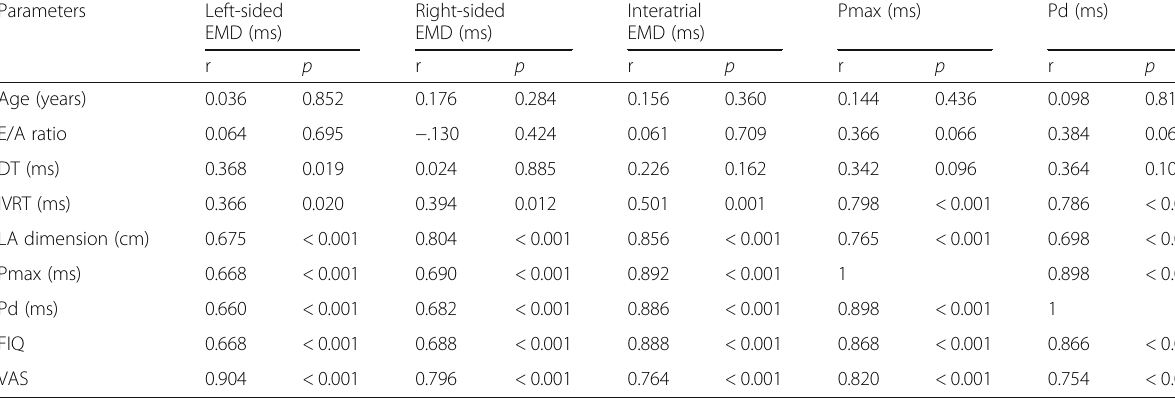
Table 5 Correlations between echocardiographic parameters of atrial conduction times, electrocardiographic parameters, clinical and laboratory characteristics of patients with FMS